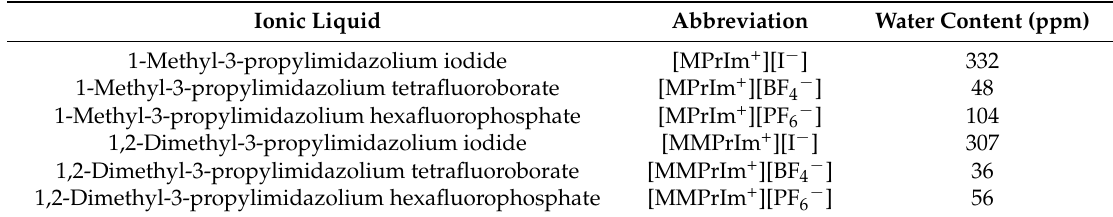
Table 1. Water content of the ionic liquids under